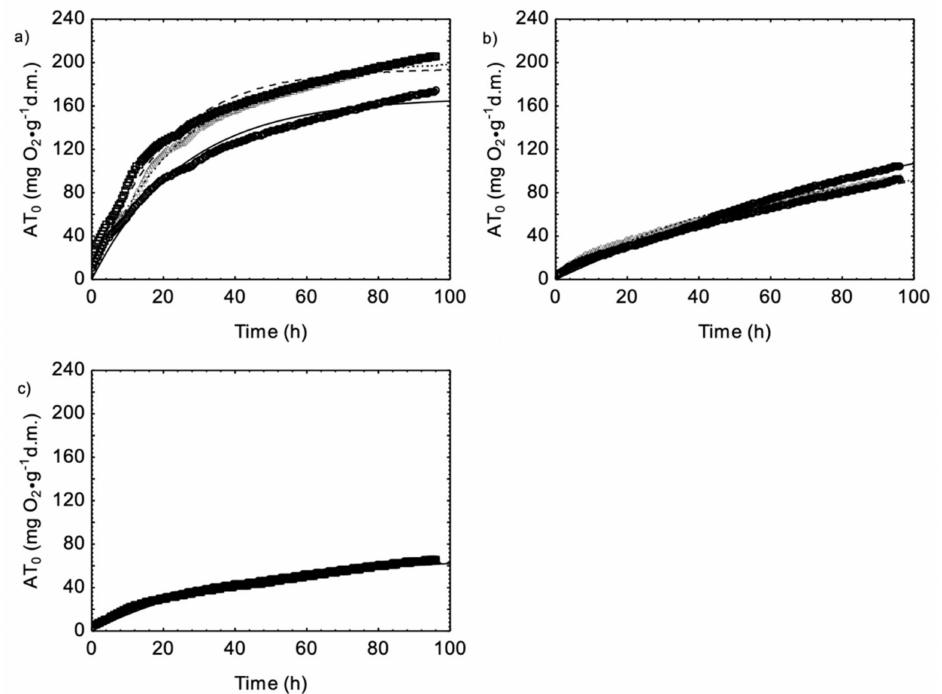
Figure 3. The respiration activity (AT0) of substrates (N = 3) and waste mix (N = 2); ( a ) grass, ( b ) manure, ( c ) mixture (di ff erent lines on figures mean